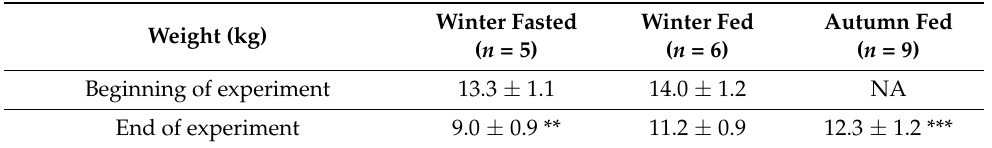
Table 1. Body weight of the raccoon dogs at the beginning and end of the experiment. Statistically significant differences are indicated with ** p ≤ 0.01 and *** p ≤ 0.001. Beginning weights of the autumn fed raccoon dogs were not available